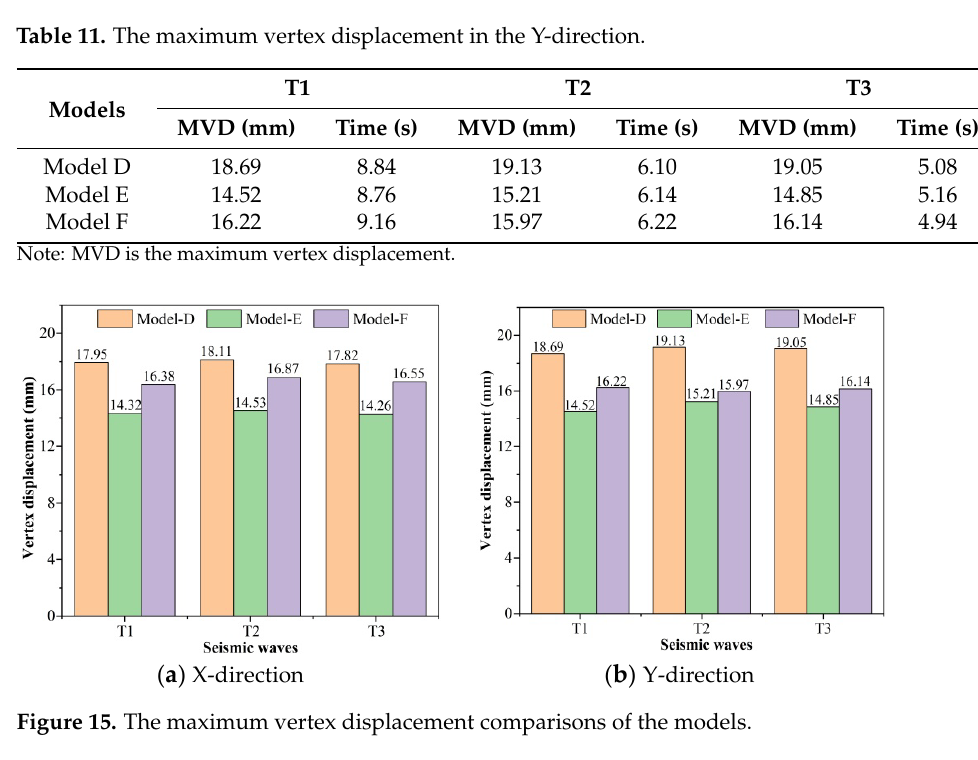
Table 12. The maximum interlayer displacement in the X-direction.